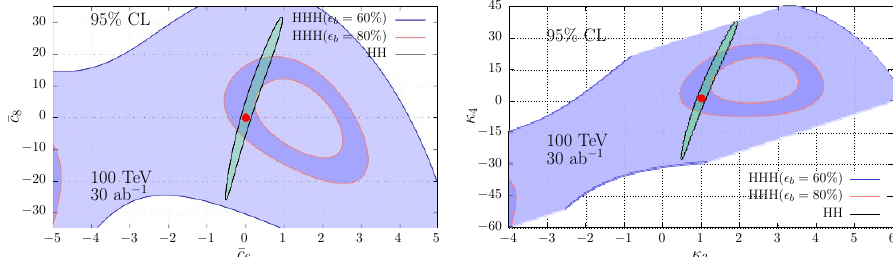
Figure 15 . Expected 1 (cid:27) and 2 (cid:27) bounds in the ((cid:22) c 6 ,(cid:22) c 8 ) plane at 100 TeV, assuming (cid:22) c true (cid:6) 4 and (cid:22) c true = 0 (denoted by red dots). 8